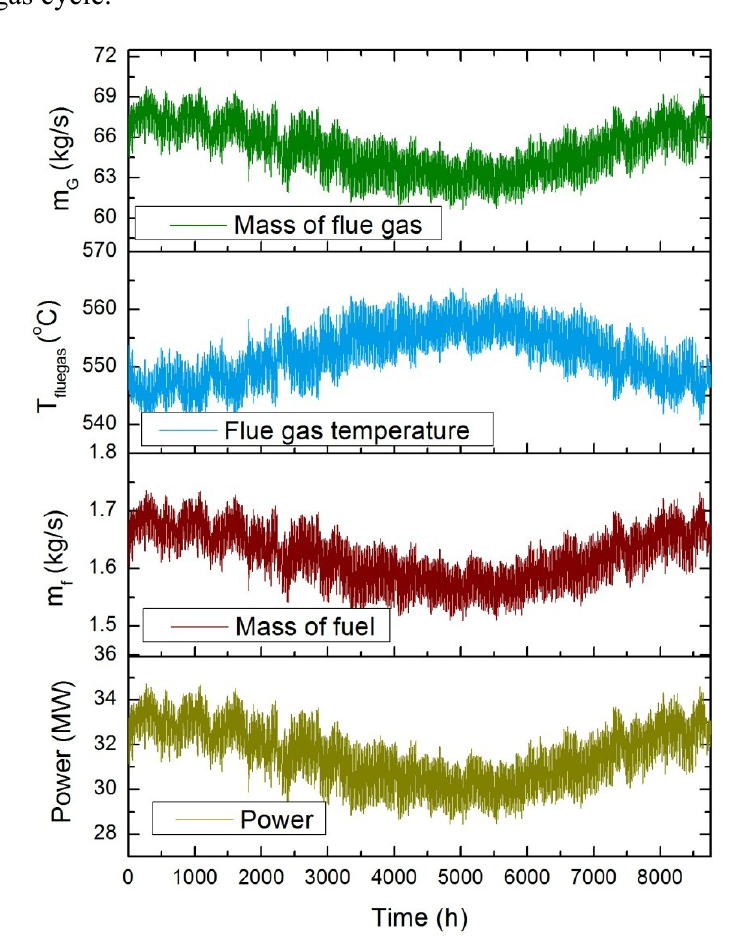
Figure 6. Annual variations in power production, rate of fuel intake and exhaust gas parameters in gas